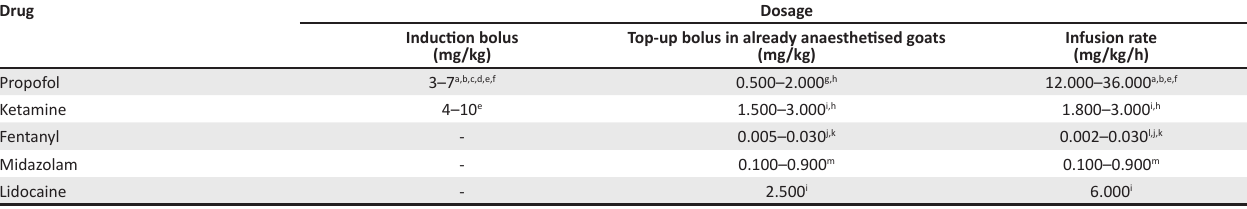
TABLE 1: Summary of referenced dosages of drugs utilisable for intravenous anaesthesia in goats. Drug